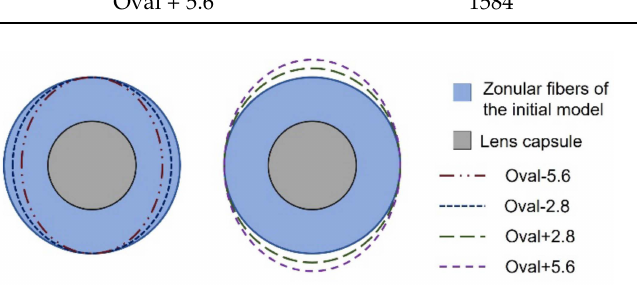
Figure 2. Frontal view schematic of the models with an oval zonular geometry.